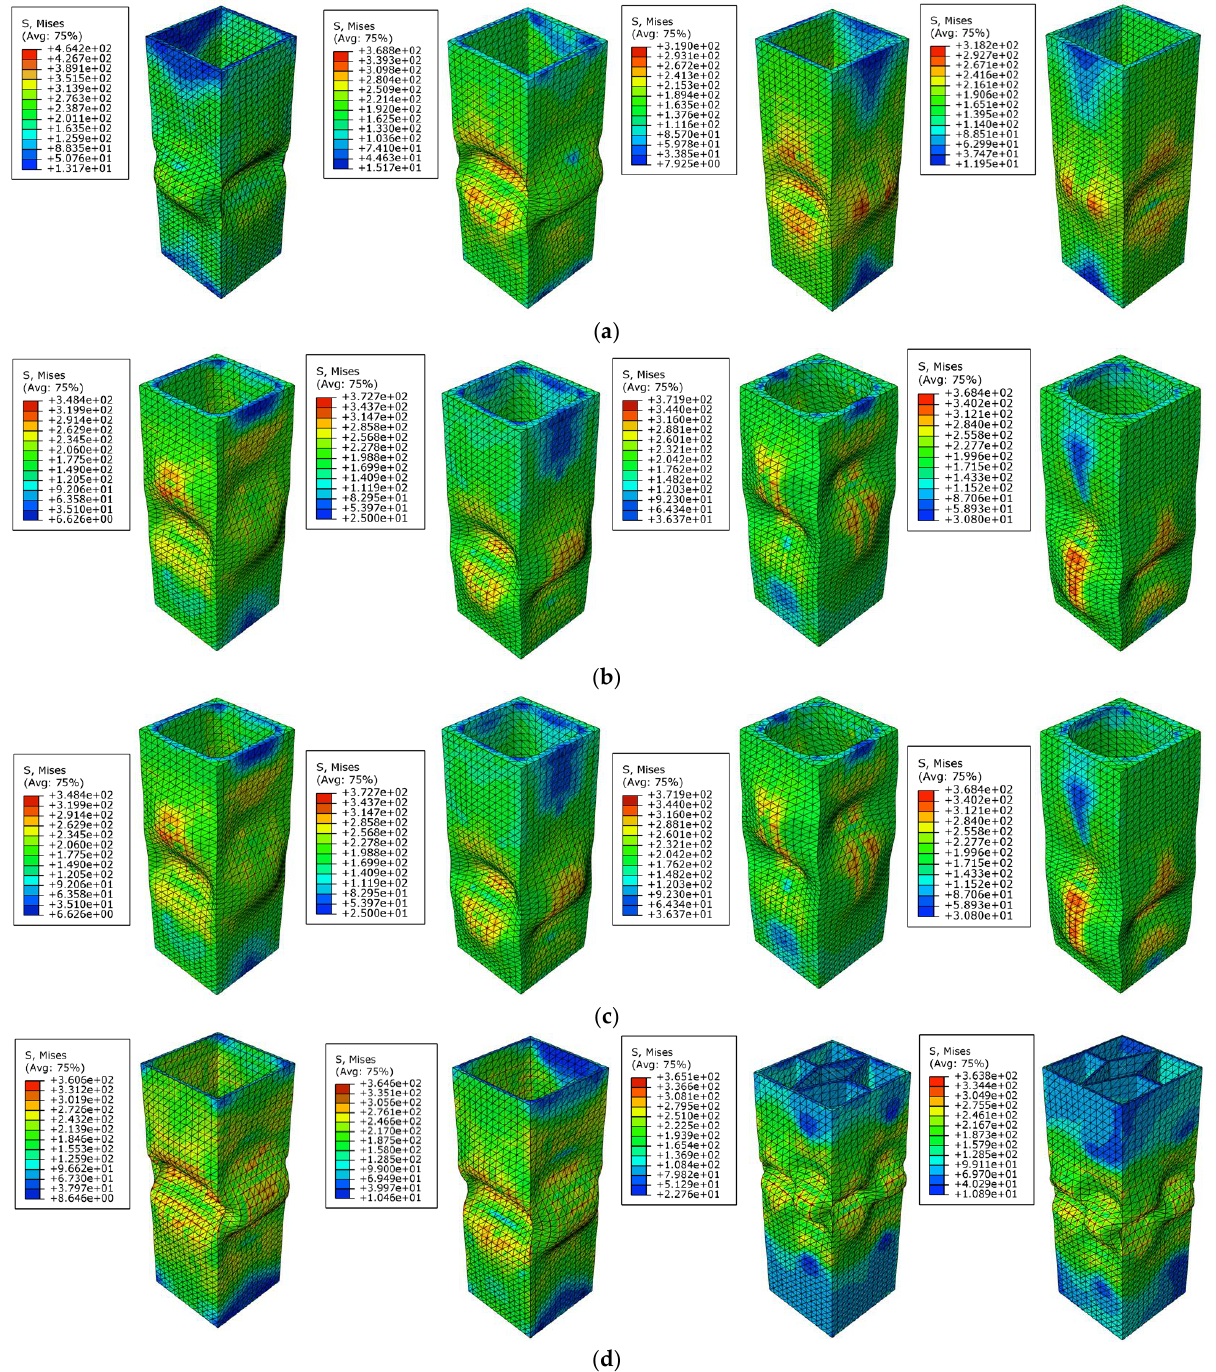
Figure 5. Stress distribution plots: From left to right: ( a ) Q1 – Q4 stocky cross-sections; ( b ) K1 – K4 stocky cross-sections; ( c ) S1 – S4 stocky cross-sections; ( d ) Q5, K5, and S5 – S6 slender cross-sections.